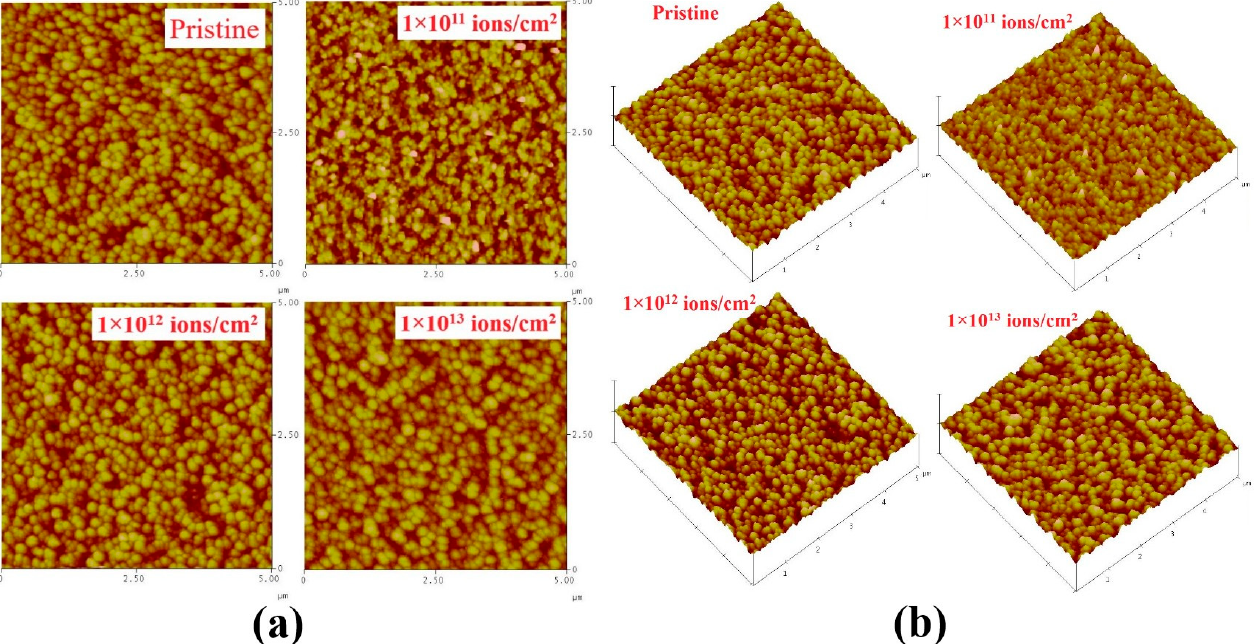
Figure 4. The 2D ( a ) and 3D ( b ) AFM images of In 2 (Te 0.98 Se 0.02 ) 3 thin